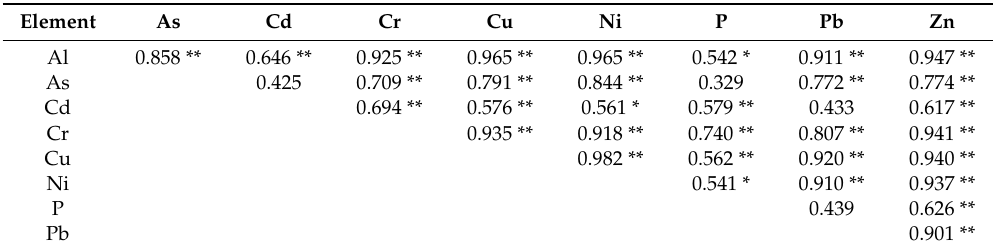
Table 3. Pearson correlation matrix for the metal